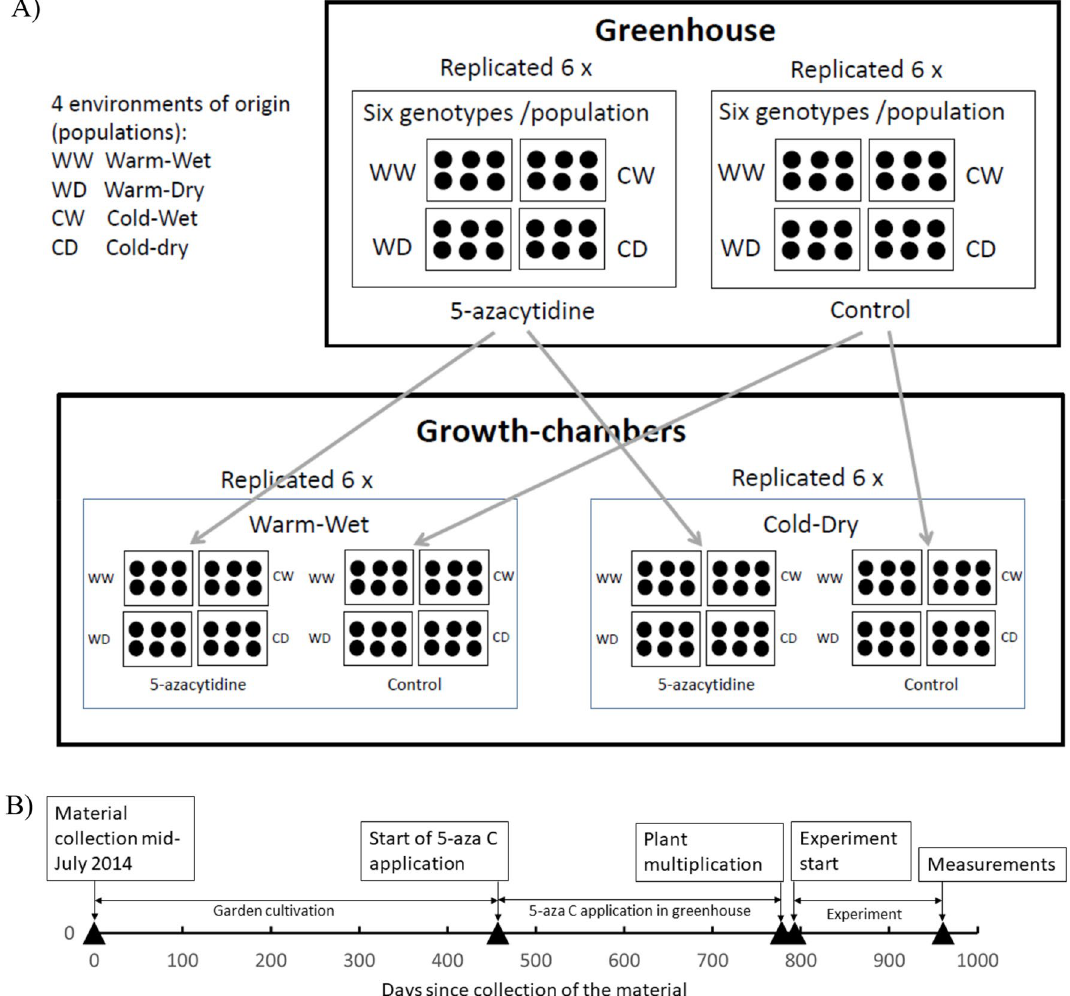
Figure 1. ( A ) The design of the experiment as previously shown in Münzbergová et al. 7 , which provided the material for the current study. ( B ) Timeline of the whole